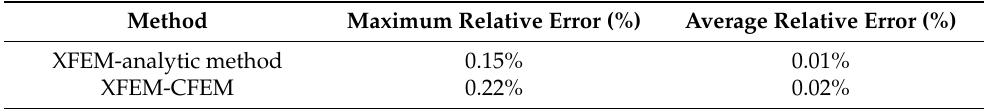
Table 2. Relative error of electric potentials on nodes.